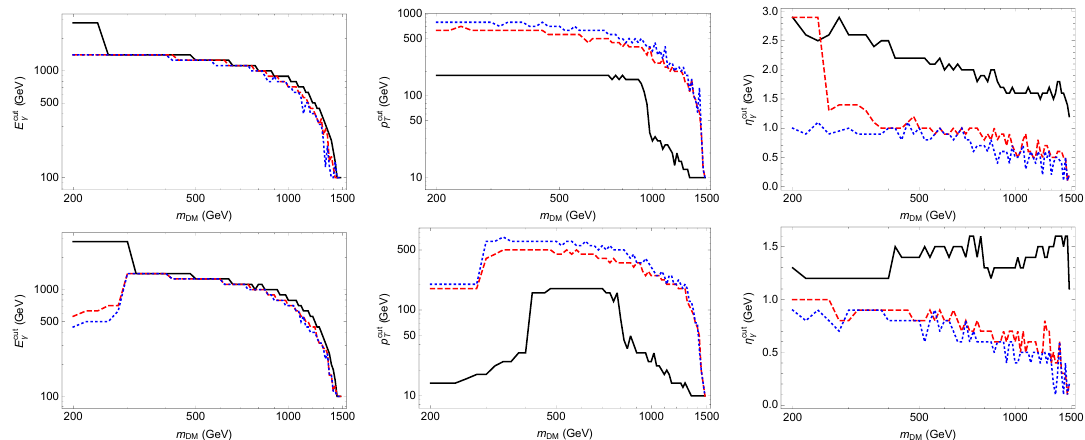
Figure 8 . Cuts that optimise signi(cid:12)cance for a fermion triplet (top) and quintet (bottom). The black solid (red dashed, blue dotted) lines are for 0% (0.5%, 1%) systematic uncertainties, when we include the photon smearing and resolution e(cid:11)ects, and for the beam polarisation ( P ( e (cid:0) ) ; P ( e + )) = ( (cid:0) ; +). The optimal cuts for other multiplets and polarisations are